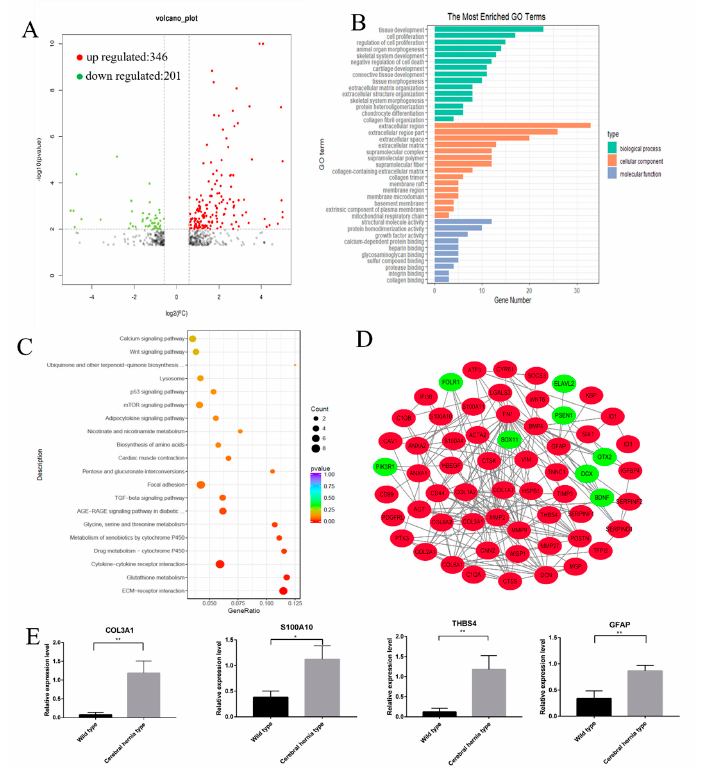
Figure 4. Transcriptomic annotation of telencephalon derived from chicken with or without cerebral hernia. ( A ) The differentially expressed transcripts in the telencephalon of wild type and cerebral hernia type chickens are grouped into upregulated and downregulated transcripts, which are marked with red and green dots, respectively. The criteria set up for the enrichment are |fold change| > 1.5 and p < 0.05. ( B ) The top 30 enriched GO terms for the differentially expressed transcripts in the telencephalon between wild type and cerebral hernia type chickens are listed as biological process (green), cellular components (yellow), and molecular function (blue). The criterion set up for the enrichment is p < 0.05. ( C ) The top 20 enriched KEGG pathways for the differentially expressed transcripts are listed and presented as the number of genes (indicated by the spot size) with significance (indicated p -value of the pathway with the spot color). ( D ) An mRNA–mRNA interaction network is constructed using the potential candidate genes involved in brain, nervous system, and blood–brain barrier (BBB) development. The upregulated and downregulated genes are denoted in red and green, respectively. ( E ) Expressions of randomly selected DEGs involved in brain and nervous system development are validated by qRT-PCR. The gene expression trends of COL3A1 , S100A10 , THBS4 , and GFAP are consistent with the tendency of RNA sequencing results. The qRT-PCR data are presented from six independent samples per group as mean SEM ( n = 6); * p < 0.05, ** p < 0.01 (Student’s t -test).